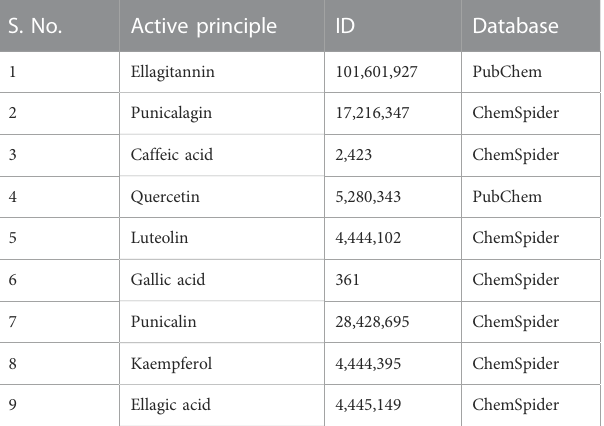
TABLE 1 Active principles of pomegranate with their respective ID and databases. S.